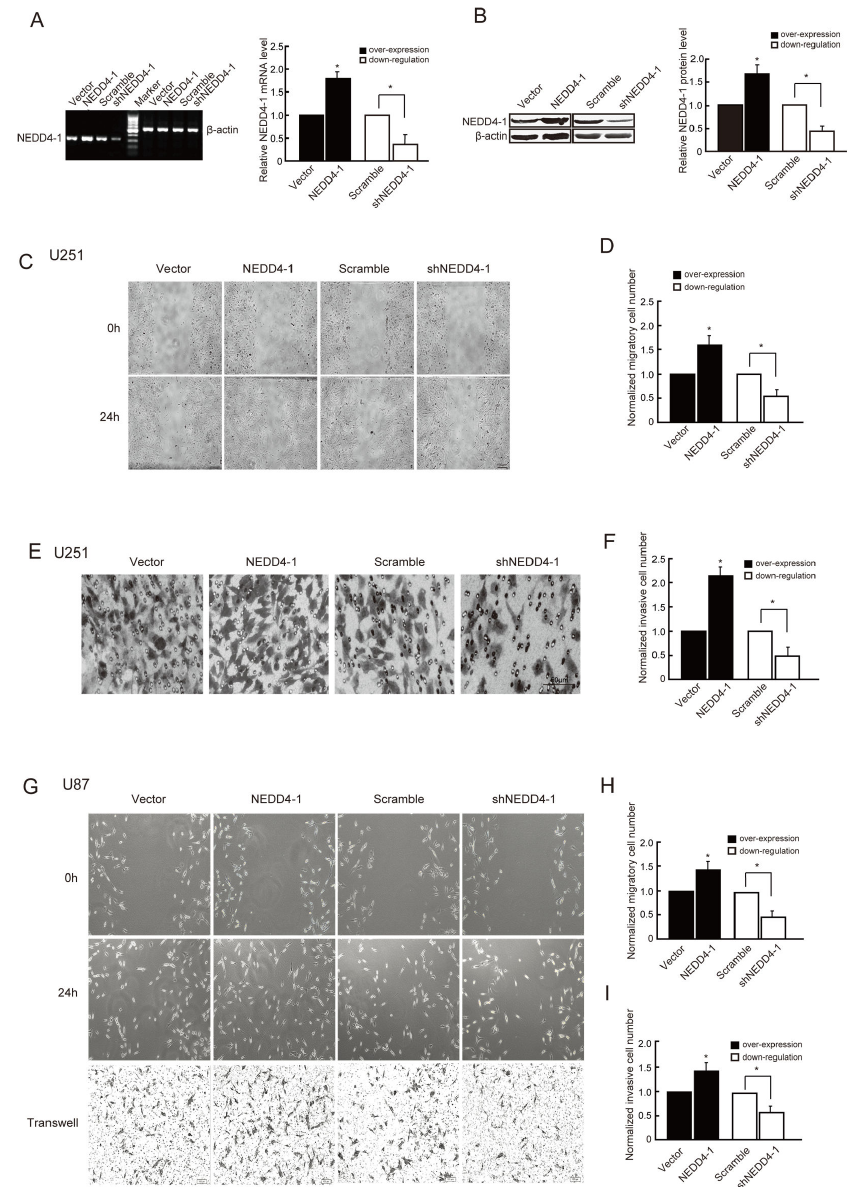
Figure 1. The effect of NEDD4-1 on cell migration and invasion. A) NEDD4-1 overexpressing or downregulating efficacy in U251 glioma cells examined by RT-PCR. Left, Representative RT-PCR analysis. Twenty-four hours after transfection, total RNAs were extracted and underwent RT-PCR analysis. β-actin was used as internal control. Right, Quantitative analysis of relative mRNA levels of NEDD4-1 normalized to those of β-actin. B) NEDD4-1 overexpressing or downregulating efficacy in U251 glioma cells detected by western blotting. Left, Representative image of western blotting. Forty-eight hours after transfection, cells were lysed and protein extraction was underwent western blot analysis using NEDD4-1 antibody. β-actin was used as the loading control. Right, Quantitative analysis of relative protein levels of NEDD4-1 normalized to those of β-actin. C) Wound-healing assay of glioma U251 cells after NEDD4-1 overexpression or downregulation. Representative digital pictures were taken at 0h and 24h. Bar: 100 μm. D) Quantitative analysis of the number of migratory cells. E) Transwell invasion assay of glioma U251 cells after NEDD4-1 overexpression or downregulation. After 48 hours of transfection, cell suspension was added into the matrigel precoated transwell chambers and the cells invaded through the matrigel were stained and photoed. Bar: 50 μm. F) Quantitative analysis of the number of invasive cells. G) Wound-healing (up and middle panel) and transwell invasion assay (bottom panel) of glioma U87 cells after NEDD4-1 overexpression or downregulation. Bar: 100 μm. H & I) Quantitative analysis of the number of migratory (H) or invasive (I) cells. Results are mean ± SEM of three independent experiments in triplicate. * P <0.05. doi: 10.1371/journal.pone.0082789.g001 PLOS ONE |